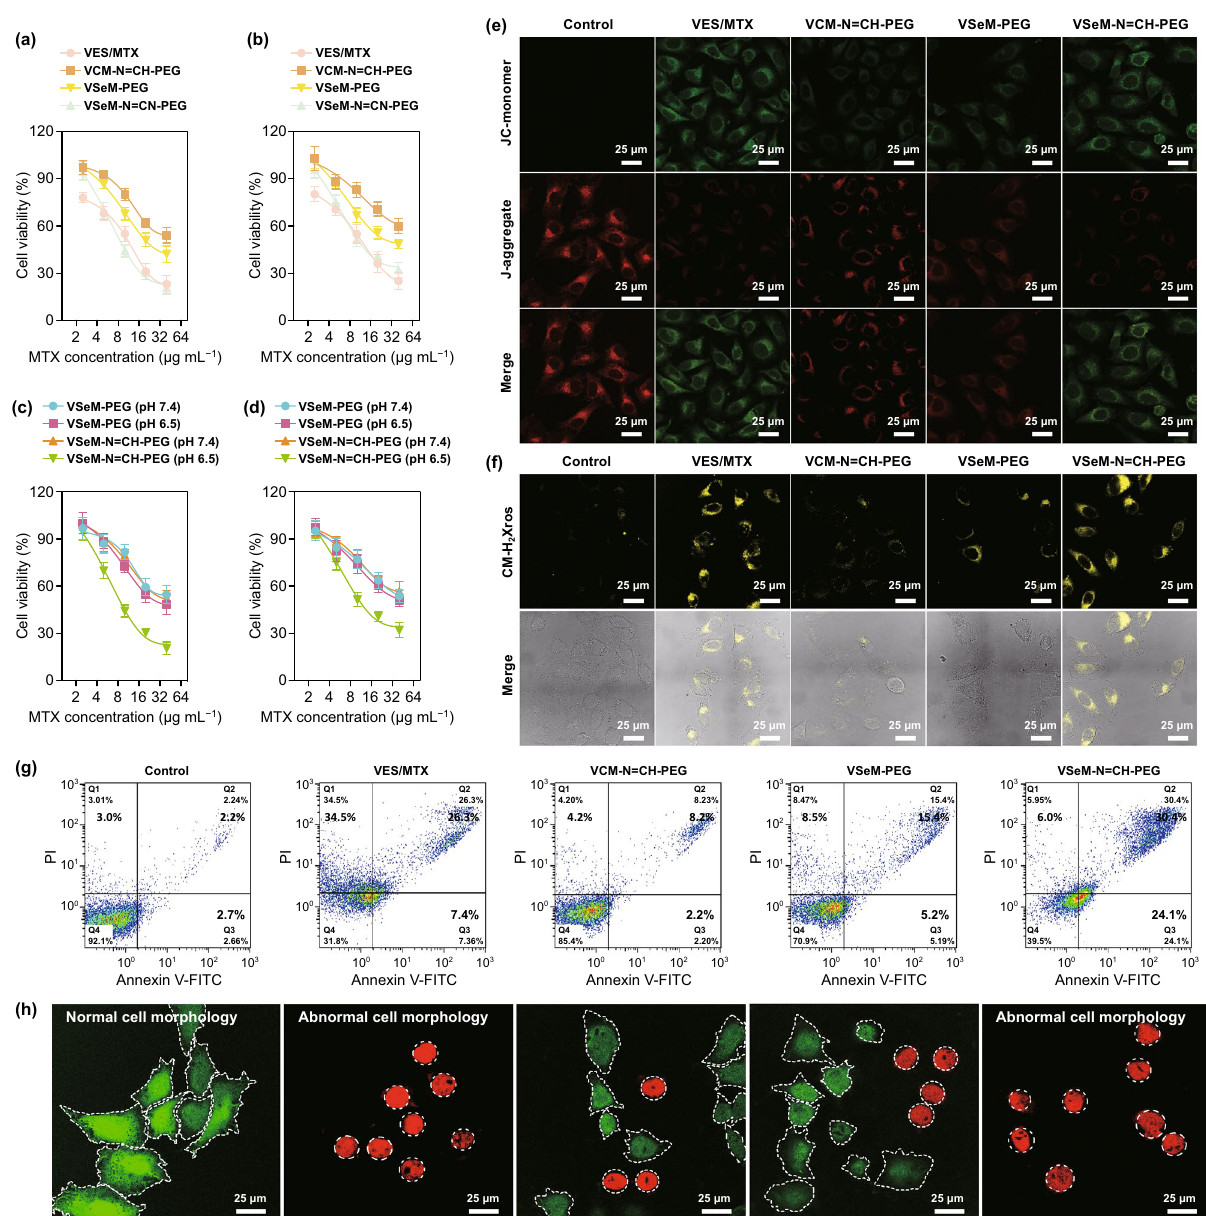
Fig. 3 In vitro anti-tumor activity. a Viability of HeLa and b MCF-7 cells treated with VES/MTX, VCM-N=CH-PEG, VSeM-PEG, and VSeM- N=CH-PEG at pH 6.5 for 24 h. c Viability of HeLa and d MCF-7 cells treated with VSeM-PEG and VSeM-N=CH-PEG at pH 7.4 and 6.5 for 24 h. e Mitochondrial depolarization using JC-1 and f cellular oxidative stress using MitoTracker Red CM-H 2 Xros in HeLa cells treated with VES/MTX, VCM-N=CH-PEG, VSeM-PEG, and VSeM-N=CH-PEG at pH 6.5 for 12 h. g Apoptosis via Annexin V-FITC/PI assay and h live- dead cell staining via Calcein-AM/PI assay of HeLa cells induced by VES/MTX, VCM-N=CH-PEG, VSeM-PEG, and VSeM-N=CH-PEG after 12 h of incubation at pH